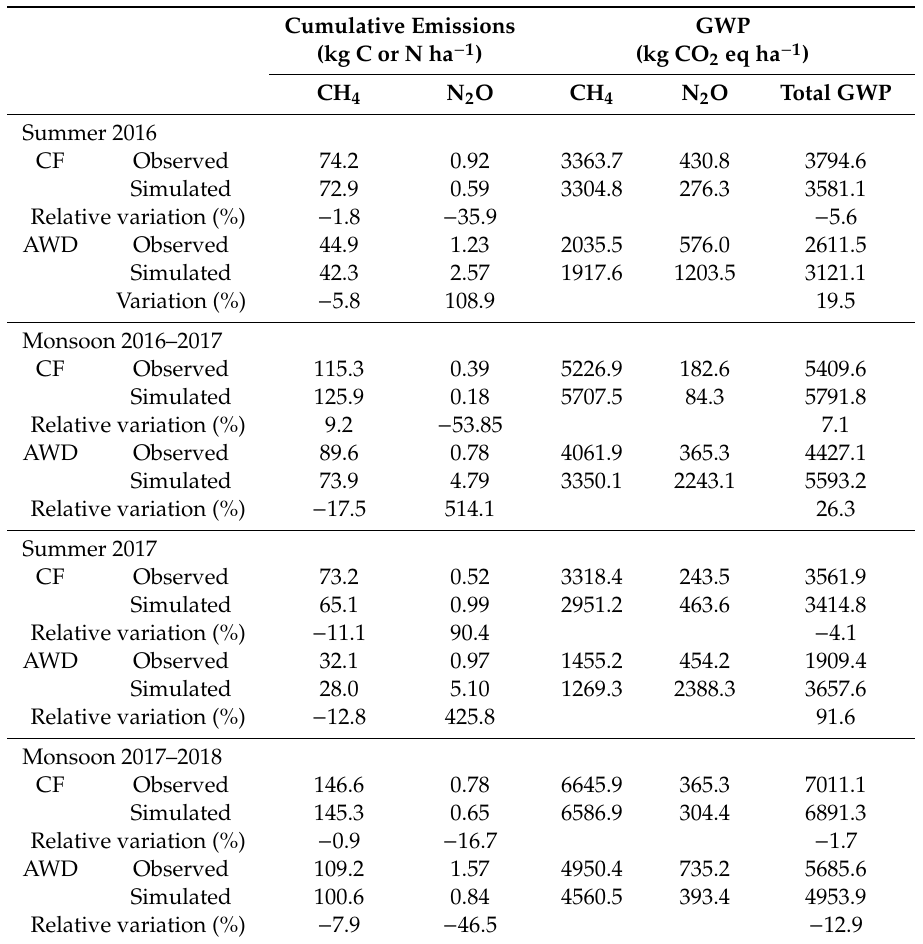
Table 4. Observed and simulated cumulative emissions and global warming potential (GWP) from rice fields under continuous flooding (CF) and alternate wetting and drying (AWD) conditions during di ff erent rice-growing